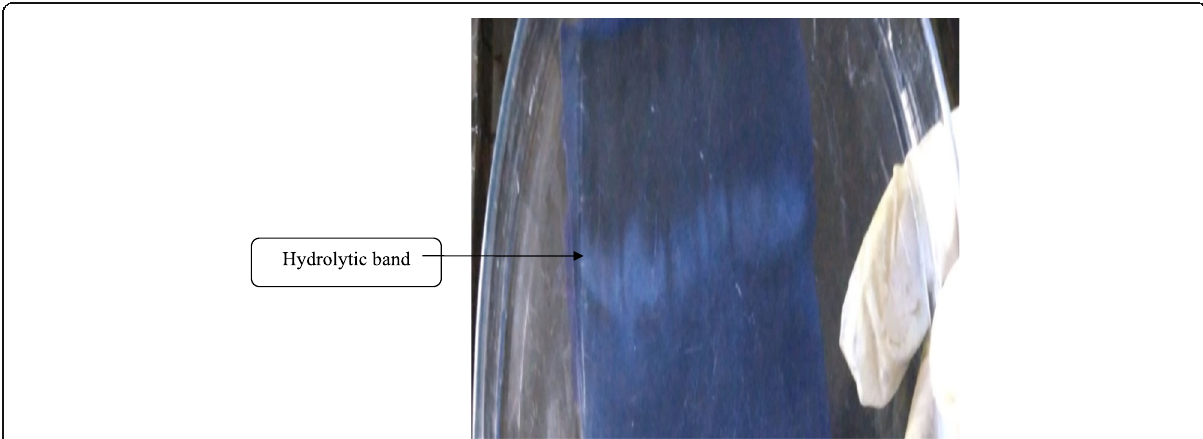
Fig. 2 Casein zymogram of purified serratiopeptidase. Purified serratiopeptidase showing a clear hydrolytic band on casein polymerized gel